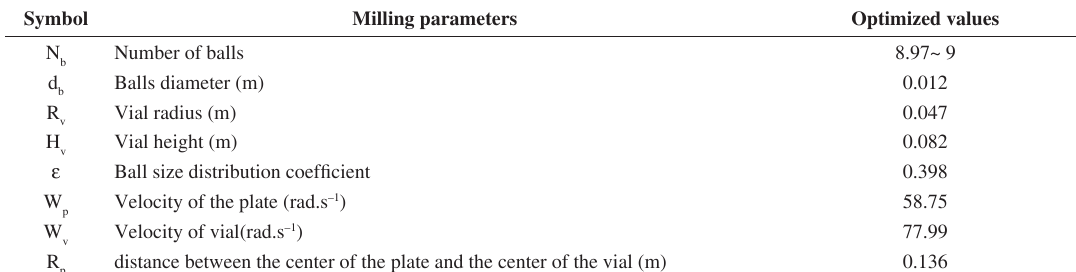
Table 2. Milling parameters optimized values in planetary mill.